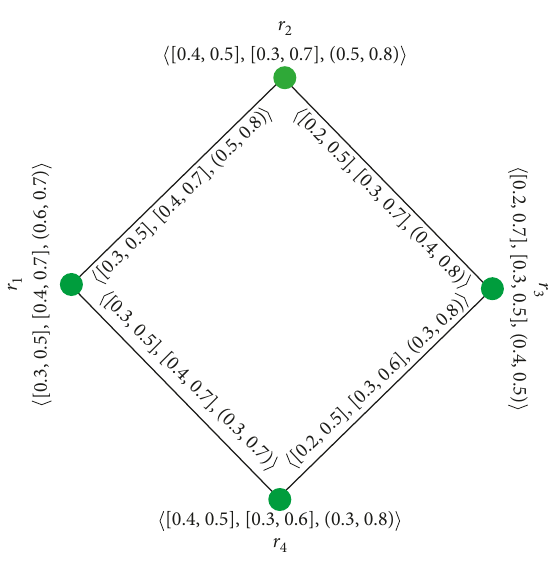
Figure 1: A cubic Pythagorean fuzzy graph G ⌣